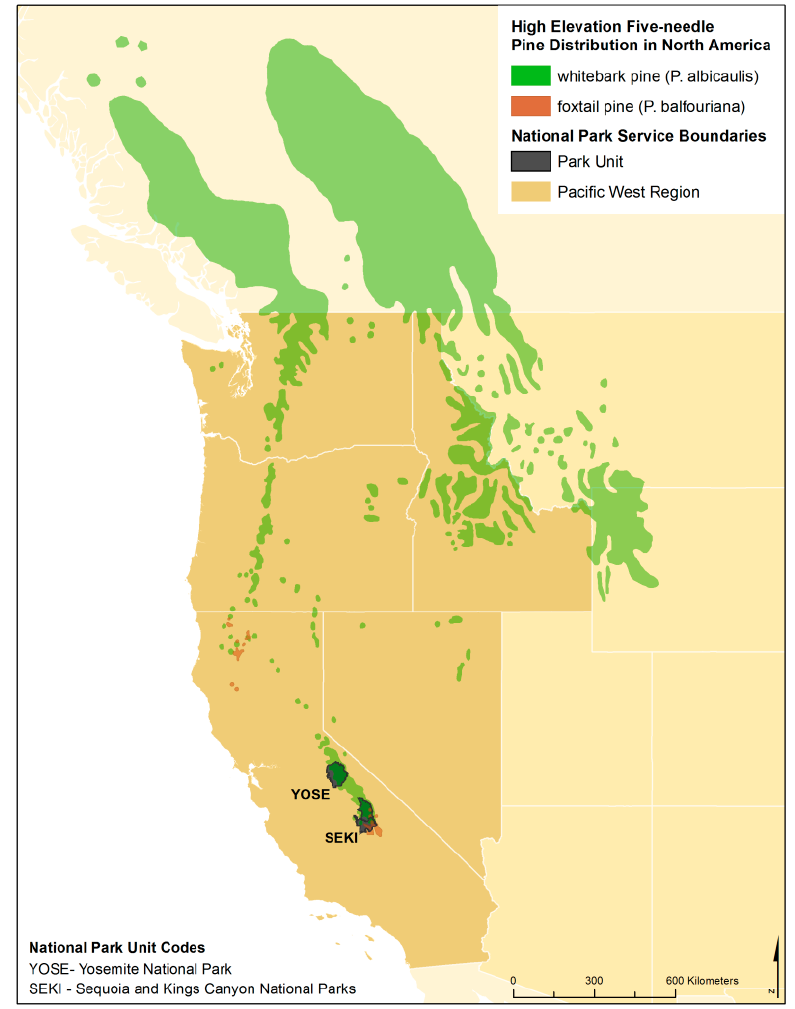
Figure 1. Distribution of whitebark pine and foxtail pine in North America and location of Yosemite, Sequoia, and Kings Canyon National Parks in the Sierra Nevada, California,